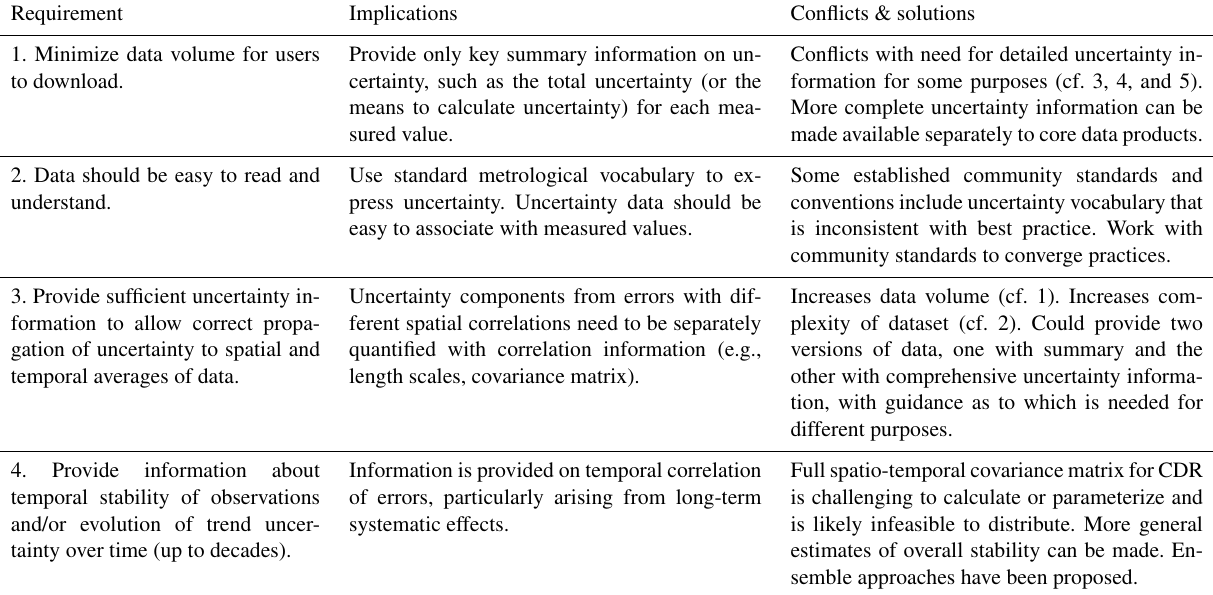
Table 2. Generic requirements for uncertainty information in climate data records, illustrating potential contradictions between the require- ments for different data